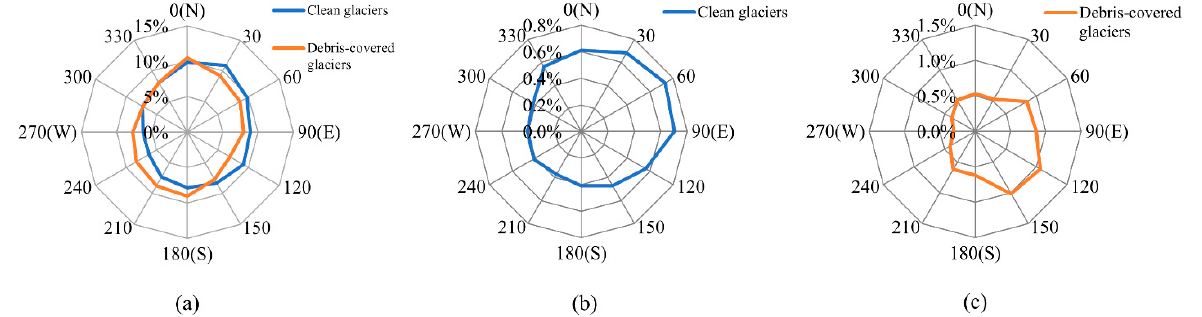
Figure 10. Glacier changes on the Tibetan Plateau in different aspects. ( a ) Percentage of area ( b ) indicates the average annual retreat rate of clean glaciers in different slopes, and ( c ) indicates the average annual expansion rate of debris-covered glaciers in different slopes.